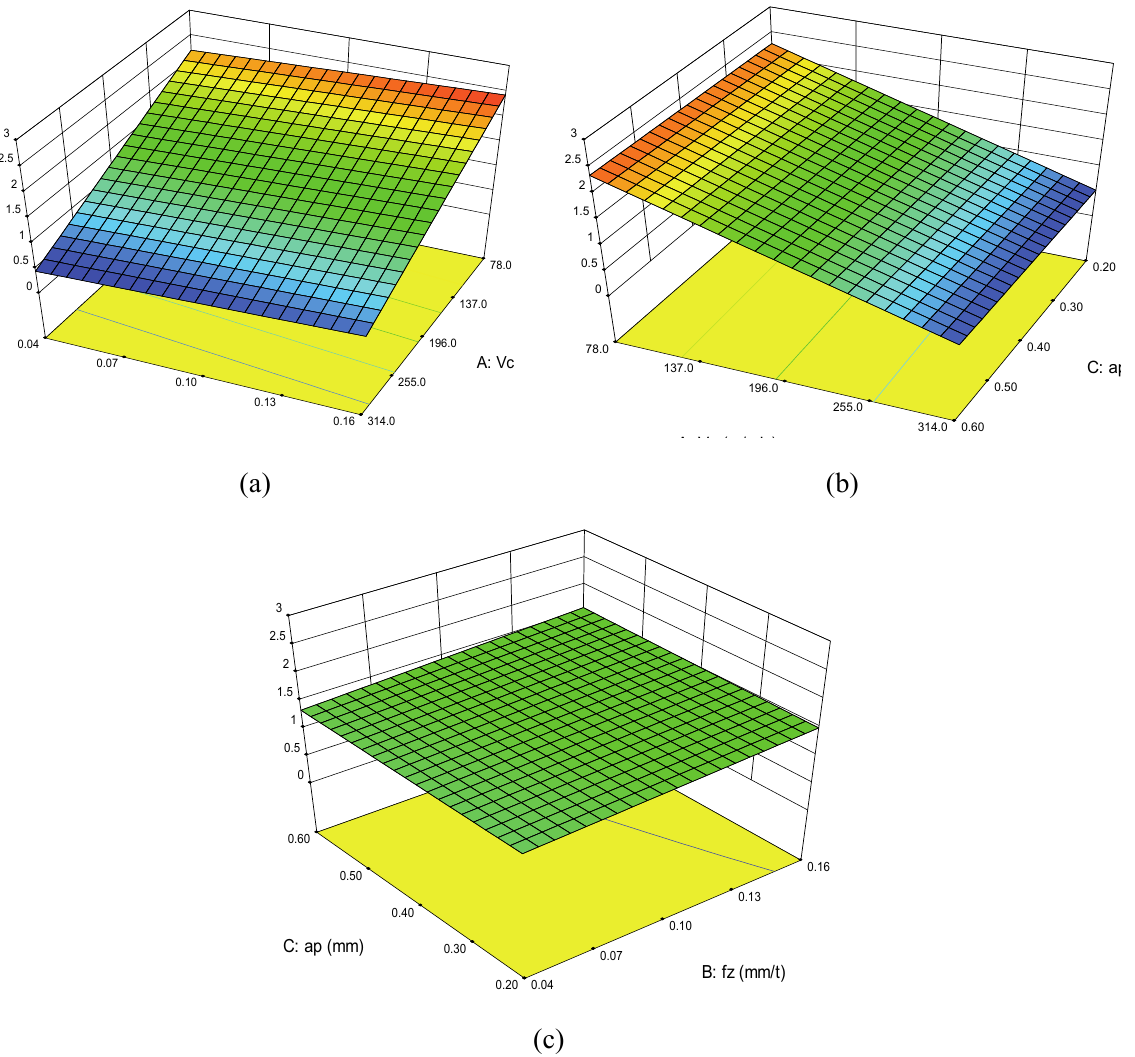
Fig. 6. Response surface for R a as a function of (Vc, fz), (Vc, ap) and (ap,